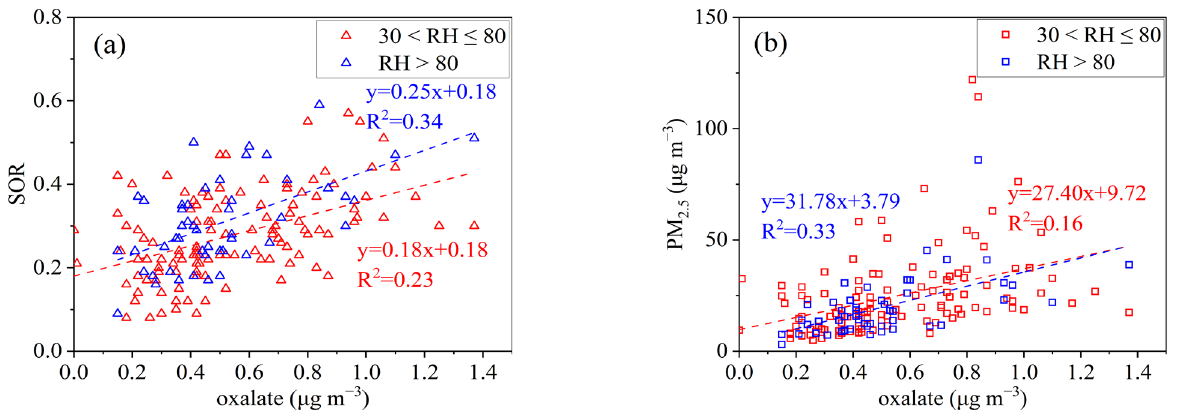
Figure 7. RH effect on particulate oxalate formation and its relationship with SOR (triangles) ( a ) and PM 2.5 (squares) ( b ). Blue triangles or squares represent samples with RH > 80, and red triangles or squares represent samples with 30 < RH ≤ 80.